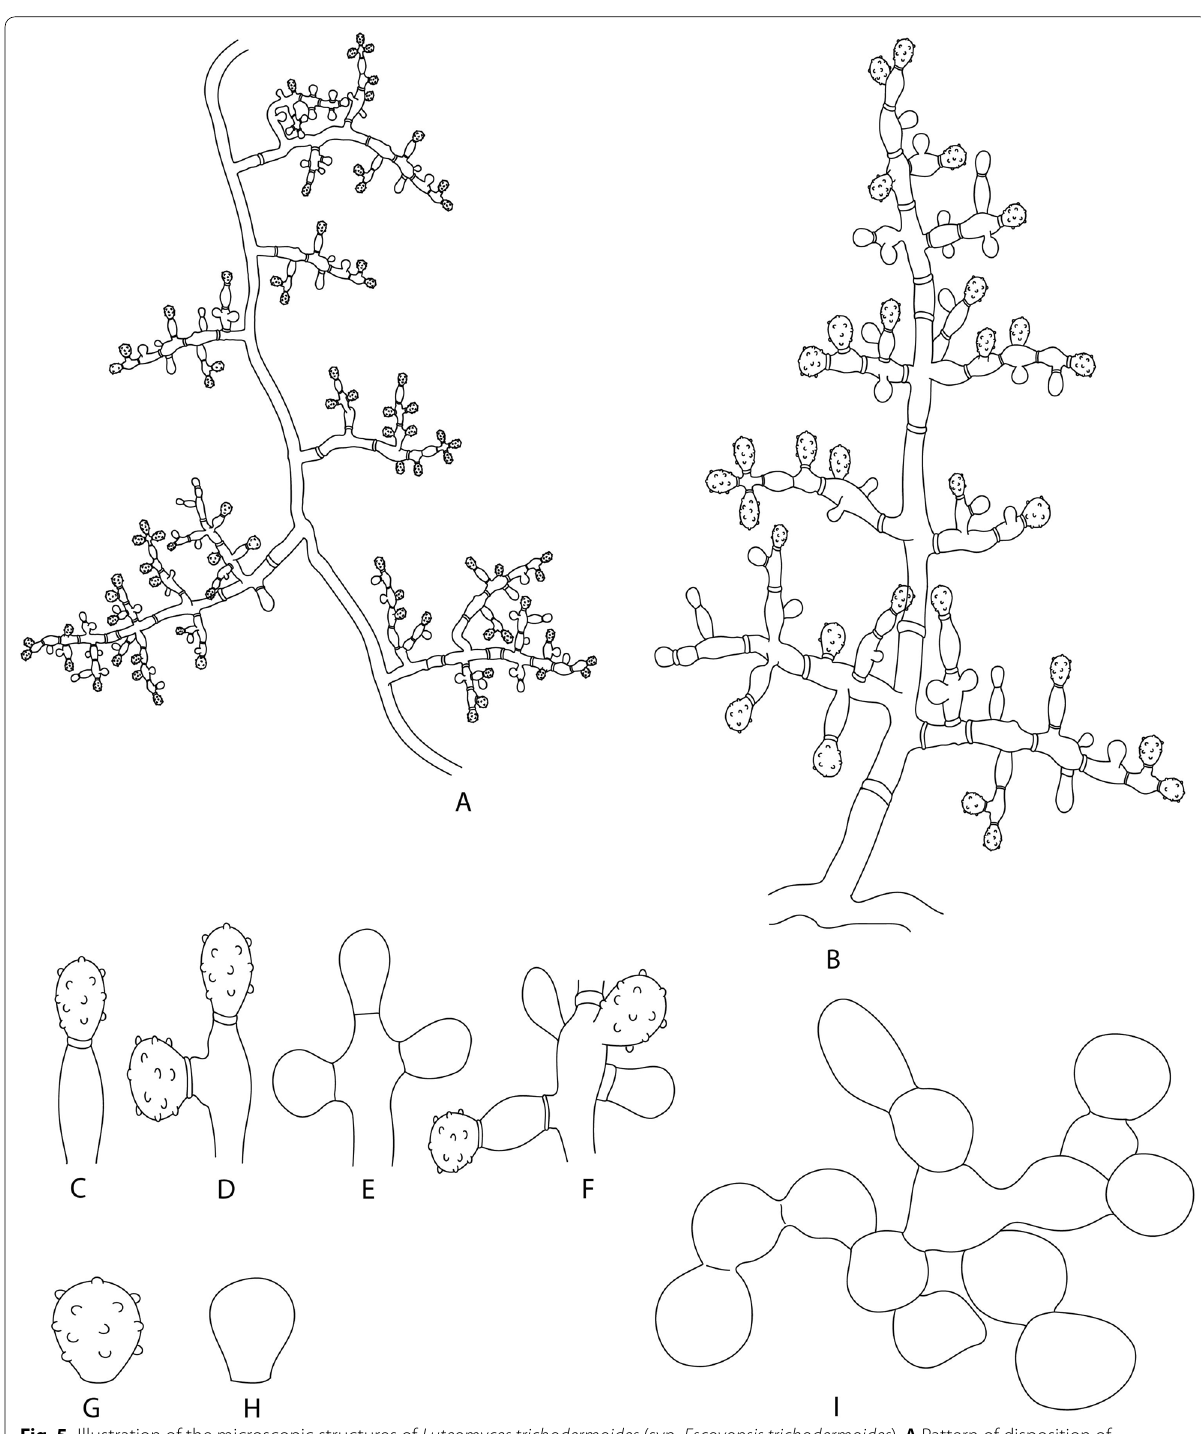
Fig. 5 Illustration of the microscopic structures of Luteomyces trichodermoides (syn. Escovopsis trichodermoides ). A Pattern of disposition of conidiophores on aerial mycelium. B A conidiophore. C – F Poorly differentiated conidiogenous cells (holoblastic determinate conidiogenous cells with synchronous arrangement). G Conidium with ornamentation. H Smooth conidium. I